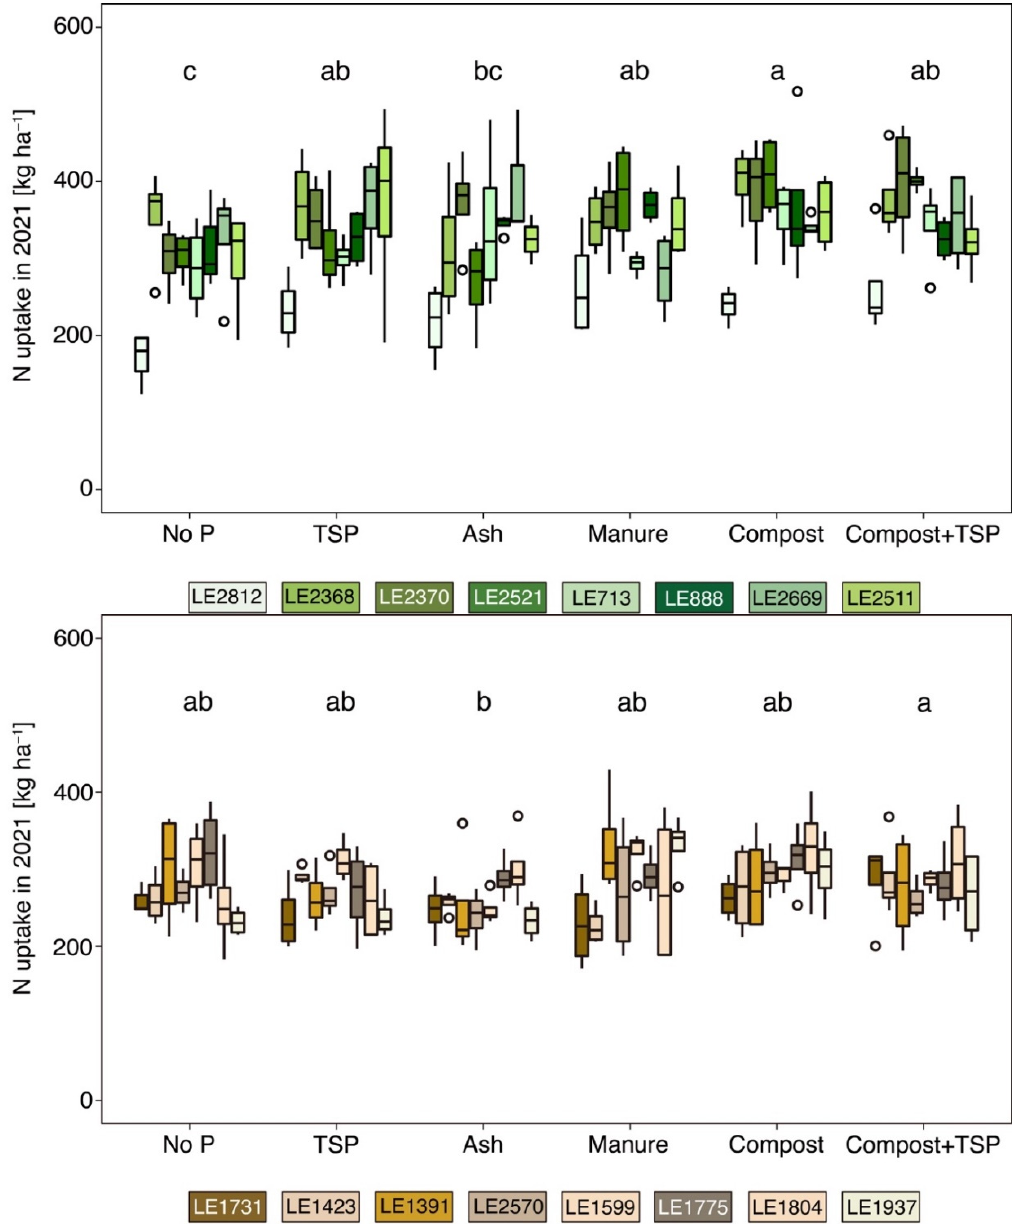
Figure 4. Plant nitrogen (N) uptake of selected accessions of alfalfa (upper part) and red clover (lower part) of the six studied treatments (no P, TSP, ash, manure, compost, and compost + TSP) in 2021. Alfalfa and red clover accessions are illustrated in different shades of green and brown colours, respectively. Letters indicate a significant difference between treatments (based on the average of accessions) within the same plant species (Duncan’s new multiple range test with p < 0.05). Mean ± standard deviation (n = 4).